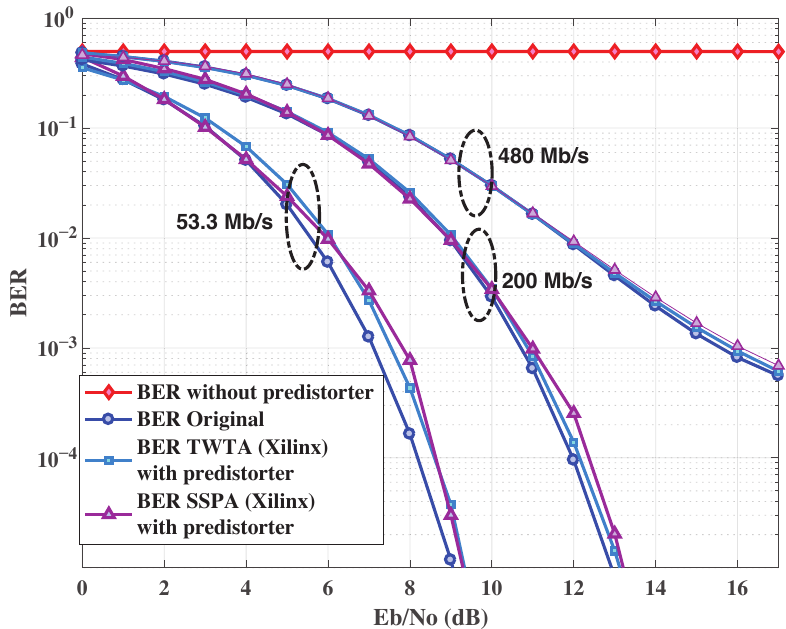
Figure 16. Bit Error Rate without and with NN pre-distorter for CM3. In Figure 18, the power spectral density (PSD) of HPA output signal with and without NN pre-distorters is shown. It can be observed that by using our proposals, the PSD regrowth is negligible. In fact, it is about 5 dB for the TWTA, whereas it is 7 dB for the SSPA, which is very reduced compared to the original